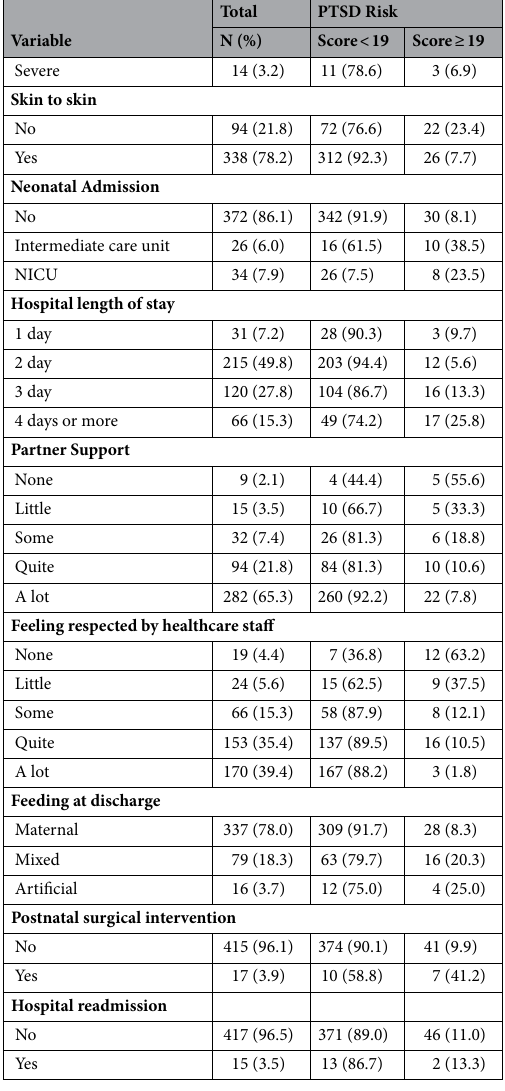
Table 1. Characteristics of the sample included in a validation study of the PPQ Spanish questionnaire for PTSD risk. CS, Cesarean section; NICU, Neonatal Intensive Care